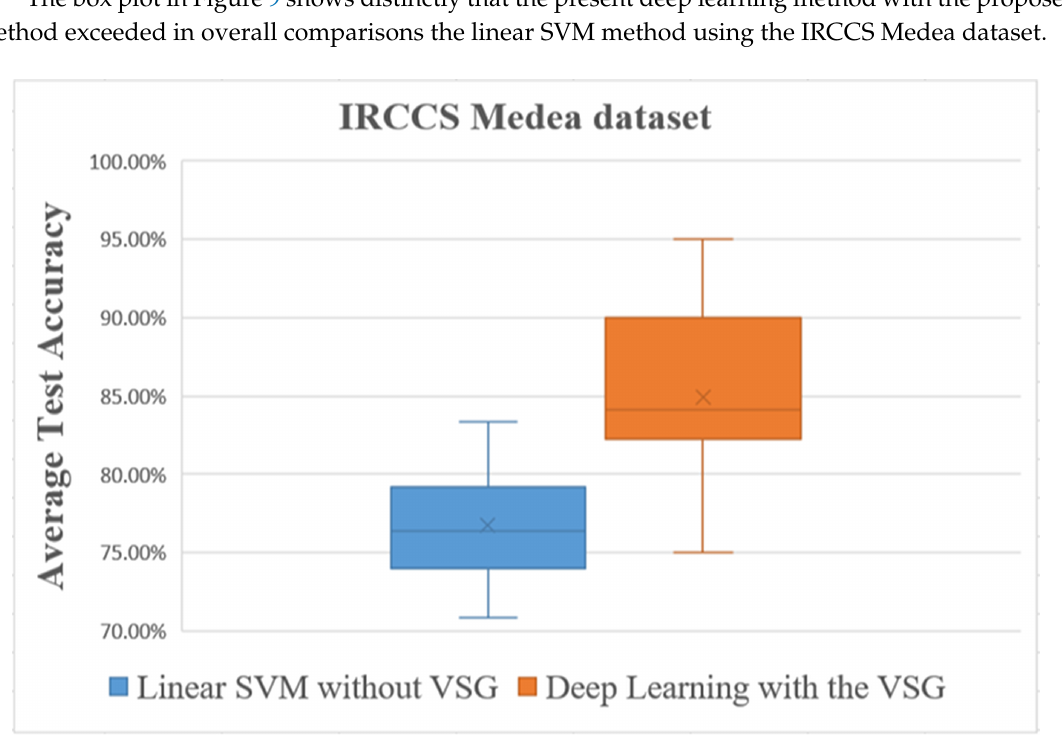
Figure 9. Overall comparisons of the experimental results using the IRCCS Medea dataset.